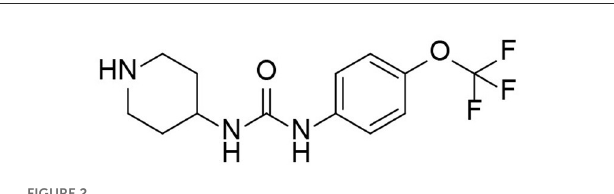
FIGURE2 Molecular structure of